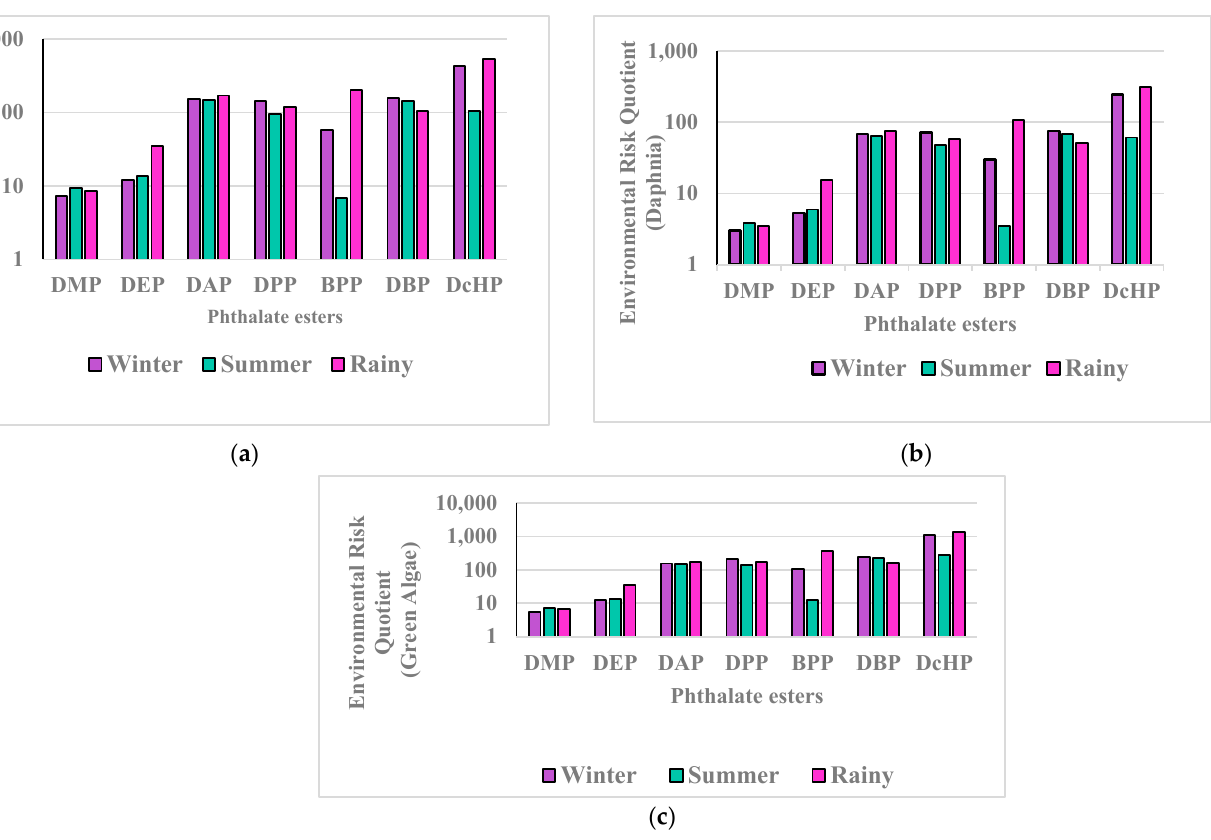
Figure 6. Aquatic risk assessment ( a ) Exposure of phthalate esters in fish of water samples for different seasons; ( b ) Exposure of phthalate esters in daphnia of water samples for different seasons; ( c ) Exposure of phthalate esters in green algae of water samples for different seasons. Table 4. Aquatic risk assessment of phthalate esters in water for fish; daphnia and green algae.